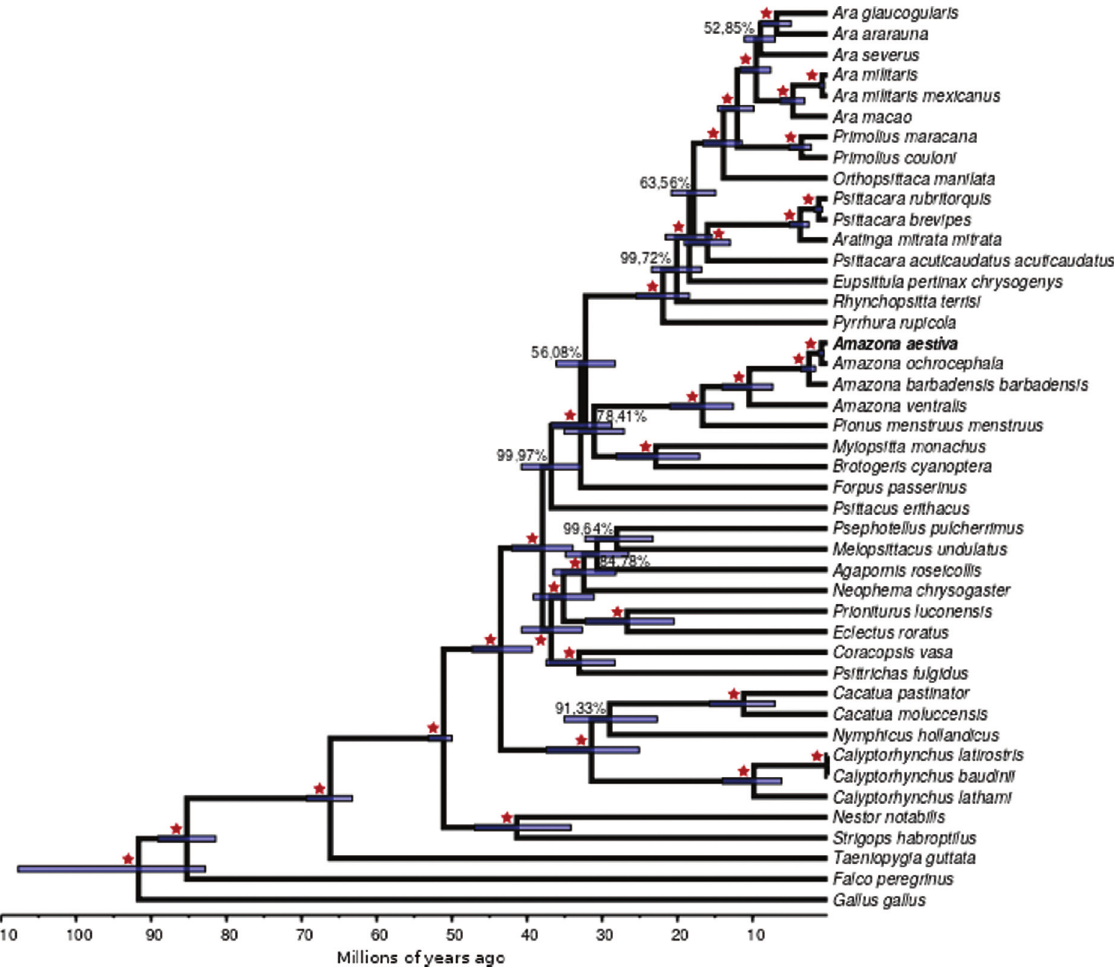
Figure 3 - Bayesian tree from all Psittaciformes with mitogenome available and three outgroups. Red stars mark branches with 100% support. Values lower than 100% are shown.